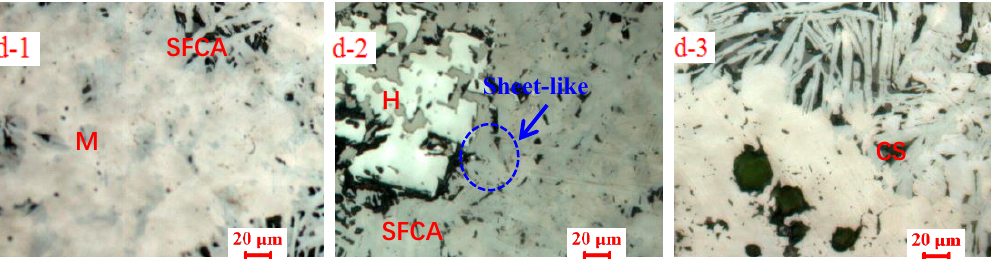
Figure 5. Effects of Al 2 O 3 content on microstructure. (a-1,a-2,a-3) Al 2 O 3 = 1.00%; (b-1,b-2,b-3) Al 2 O 3 = 1.55%; (c-1,c-2,c-3) Al 2 O 3 = 1.80%; (d-1,d-2,d-3) Al 2 O 3 = 2.25%; M — magnetite; H — hematite; CS — silicate.